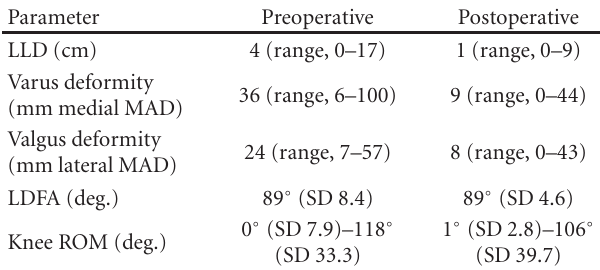
Table 1: Results for entire